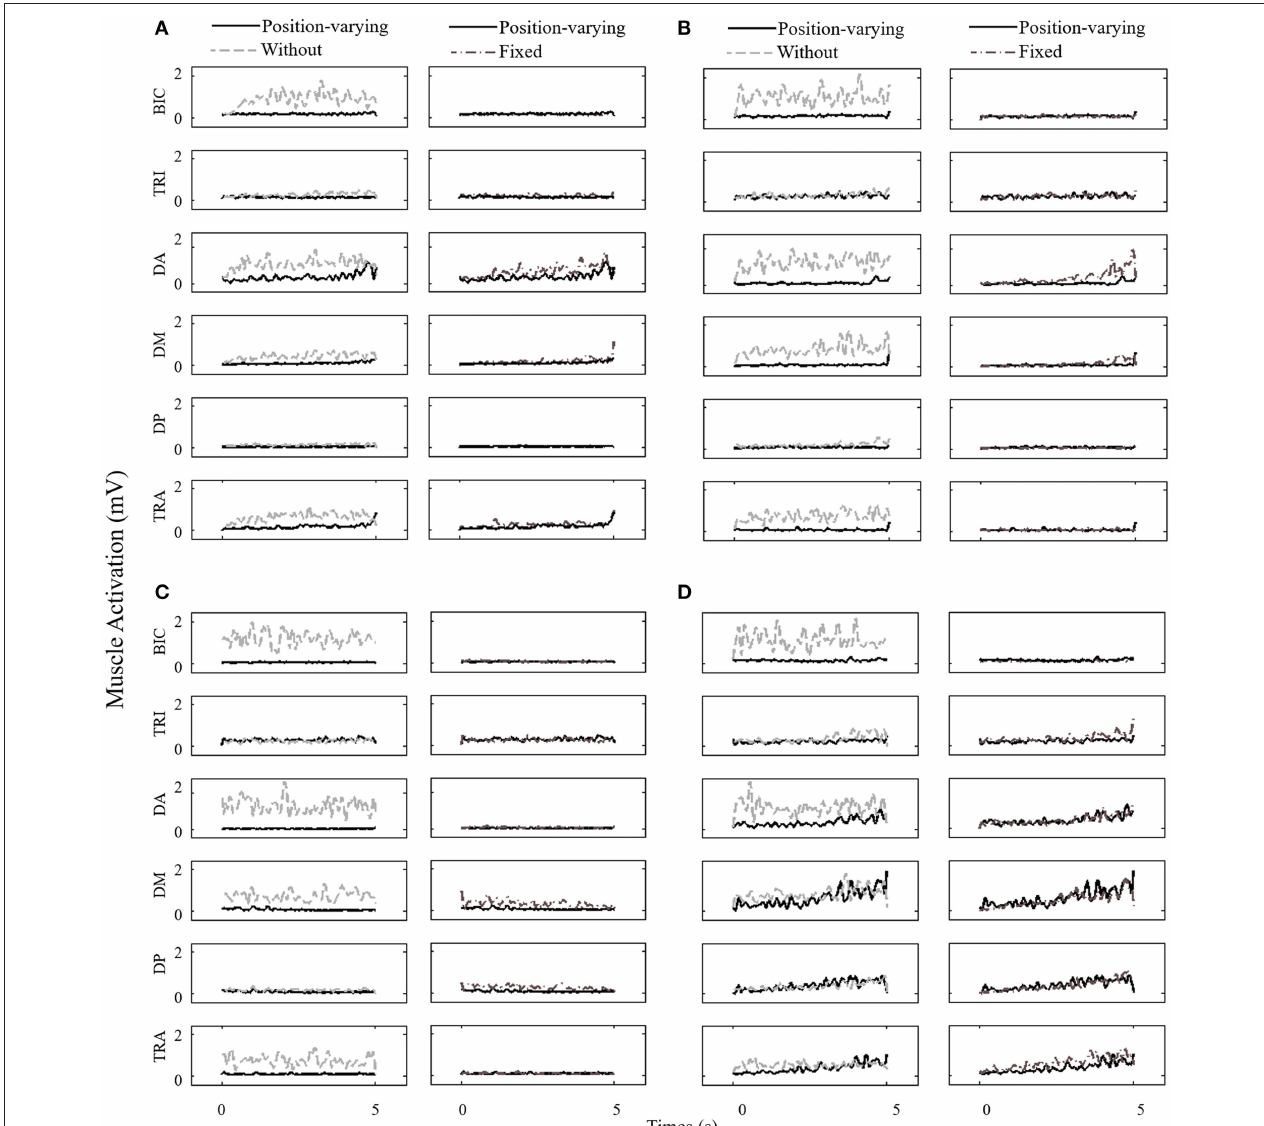
FIGURE 4 | EMG envelope time series of one subject for all muscles monitored during the study. The data is shown for three gravity compensation strategies (without, fixed, and position-varying) and for the following six muscles: BRI, TRI, DA, DM, DP, and TRA. (A) Upward, (B) Forward, (C) Leftward, and (D) Rightward.